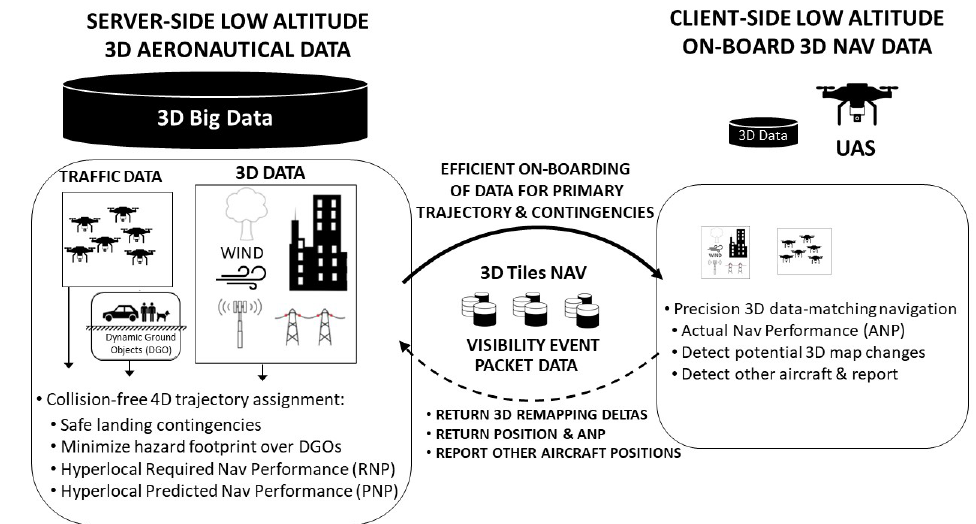
Figure 2. A common protocol for 3D data delivery supporting trajectory-based operations and performance-based navigation in the low altitude urban